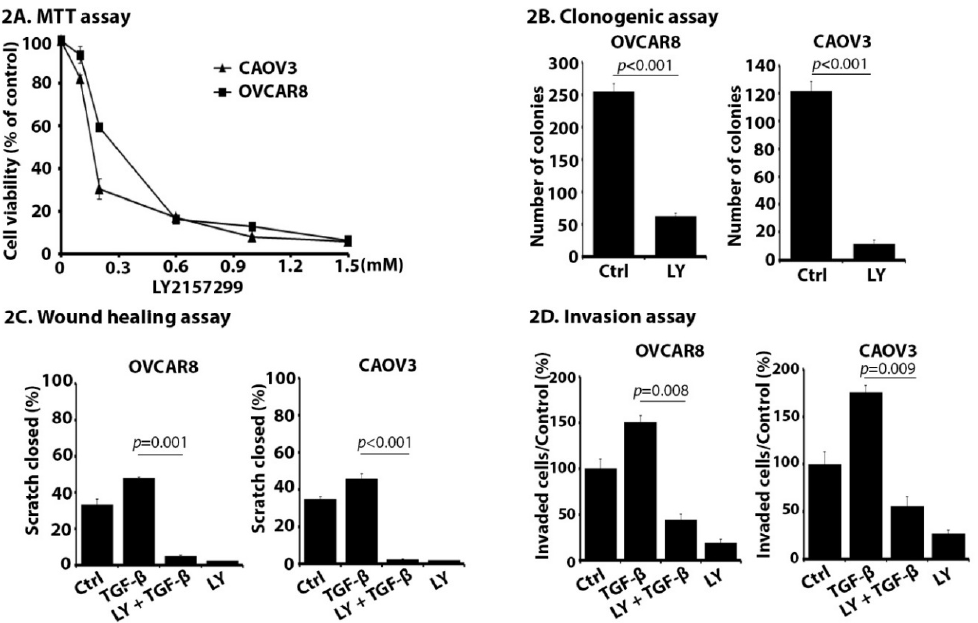
Figure 2. LY2157299 monohydrate (LY) suppresses proliferation, migration, and invasion in high-grade serous ovarian cancer (HGSOC) cell lines in vitro. OVCAR8 and CAOV3 cell lines were treated with LY with or without TGF- β 1 followed by ( A ) MTT cell proliferation assay, ( B ) Clonogenic assay, ( C ) Wound-healing assay, and ( D ) Matrigel invasion assay. All data represent the mean ± SD of three independent experiments.